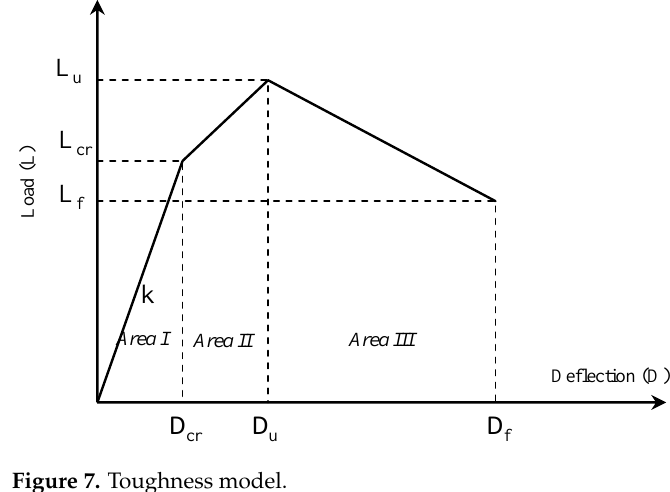
Figure 7. Toughness model.